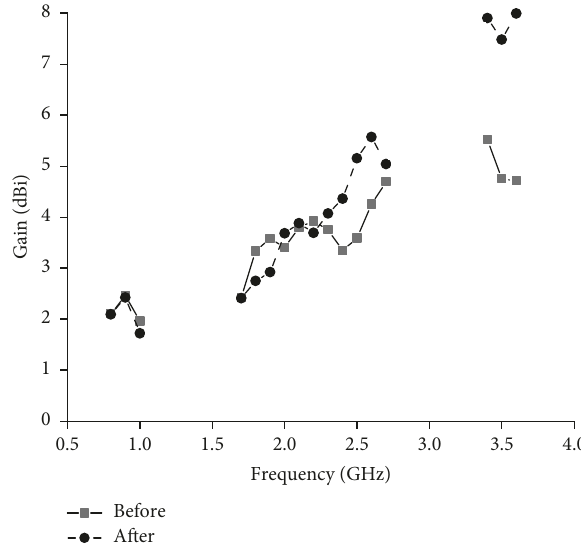
Before Figure 8: The gain of the antenna before and after halving.